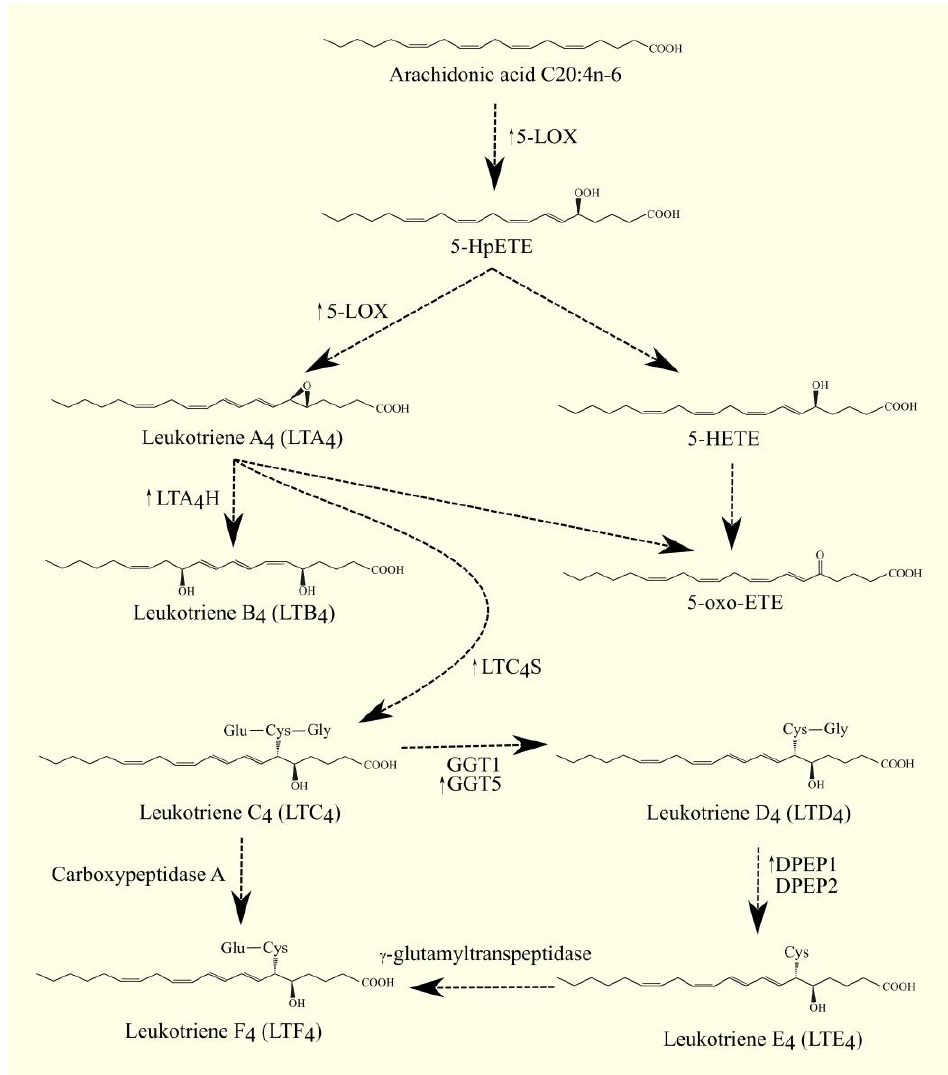
Figure 4. 5-LOX pathway. ARA C20:4n-6 is converted to 5-HpETE with 5-LOX. This enzyme